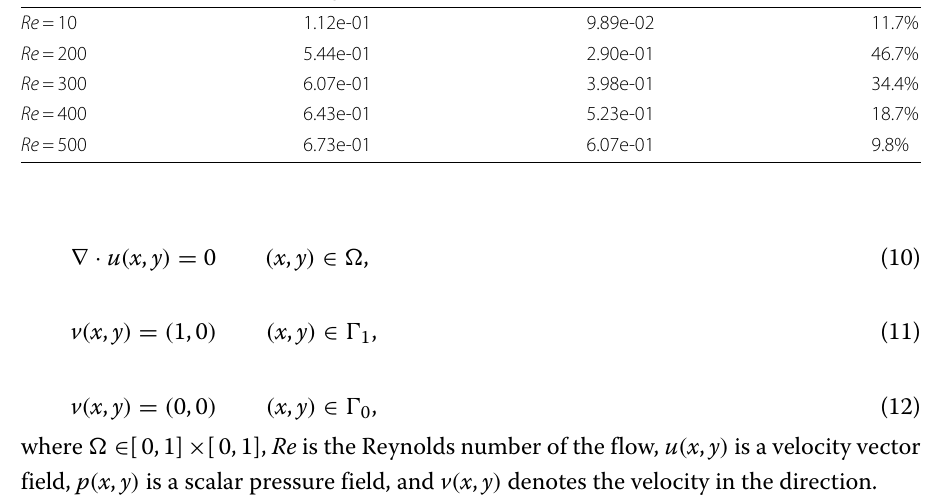
Table 4 Performance boost of PINN on the Navier-Stokes equations using transfer learning Subtask